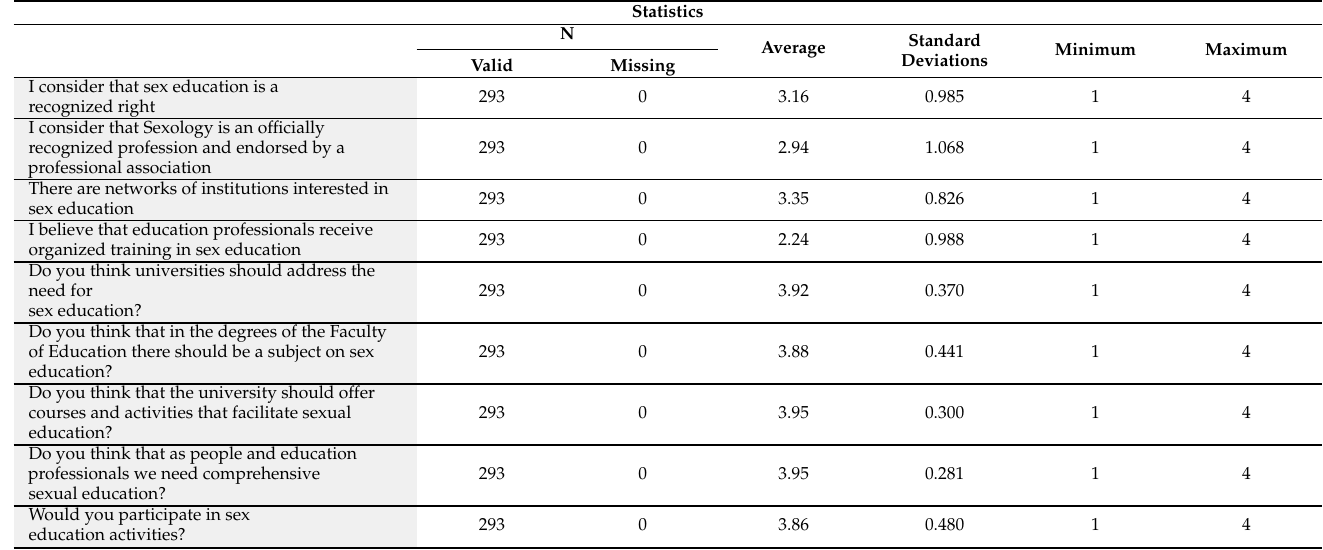
Table 2. Descriptive analyses of the need for the importance of comprehensive sexual